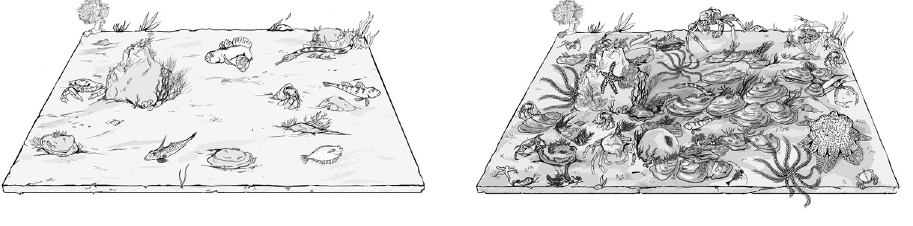
Fig 8. Infographic demonstrating the change in biodiversity over six years. (Credit: Sioˆn